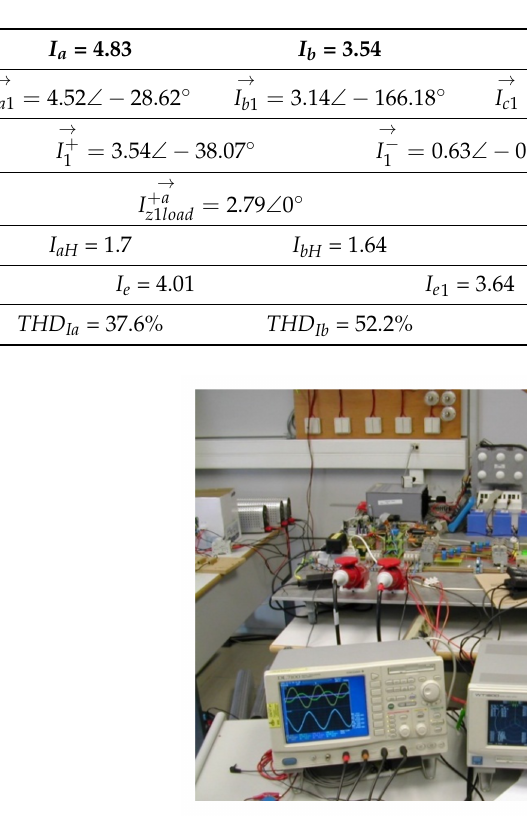
Table 4. Main load current magnitudes (in amps).